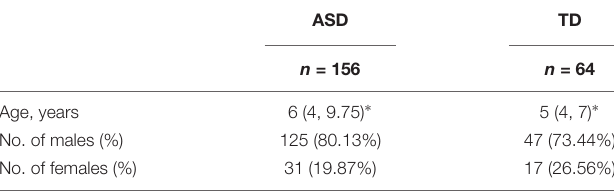
TABLE 1 | Characteristics of ASD group and TD group.